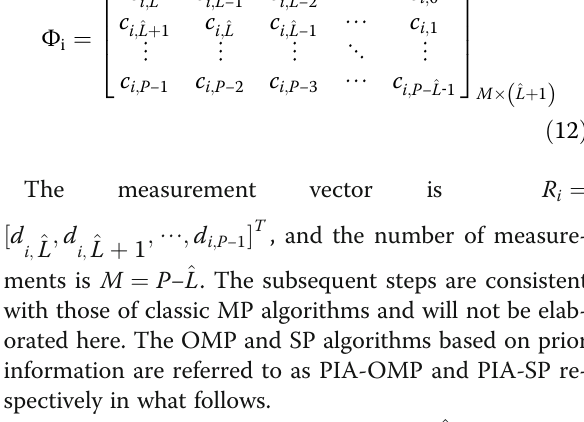
Table 2 The reference signal and spectral efficiency comparison Channel estimation scheme